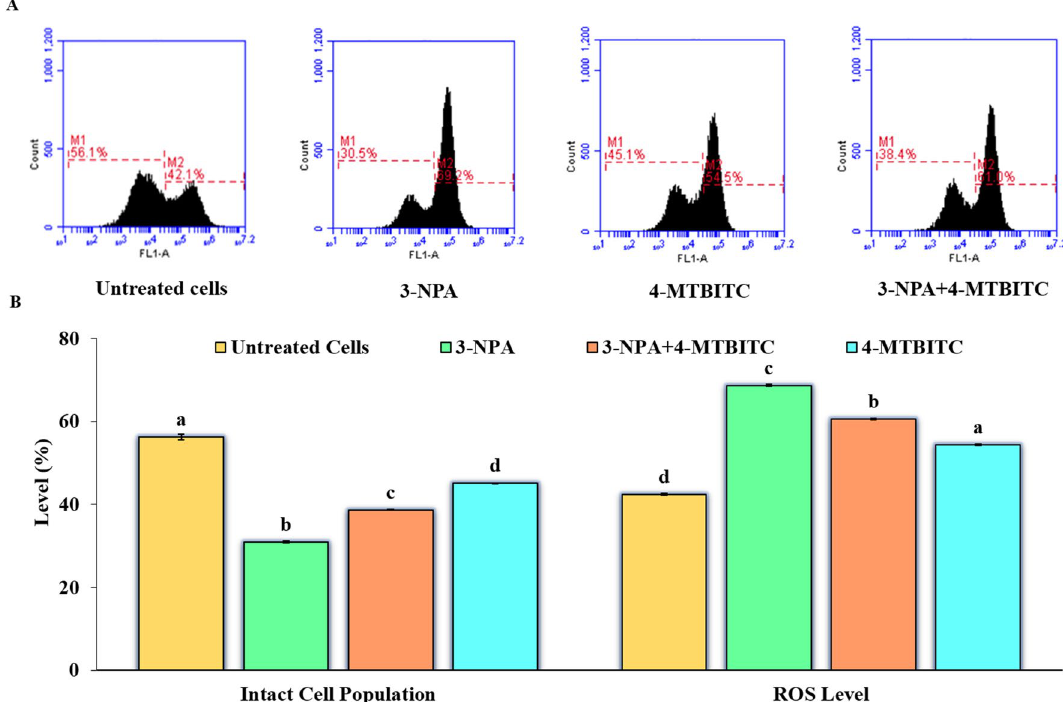
Figure 6. ( A ) The flow cytometric representation of Intracellular reactive species level detected by the fluorescent probe DCFH-DA. M2 represents the proportion (%) of ROS accumulated cells in comparison to live cells depicted as M1 phase. ( B ) Quantification of flow cytometry results. Results are expressed as the mean ± SE of three